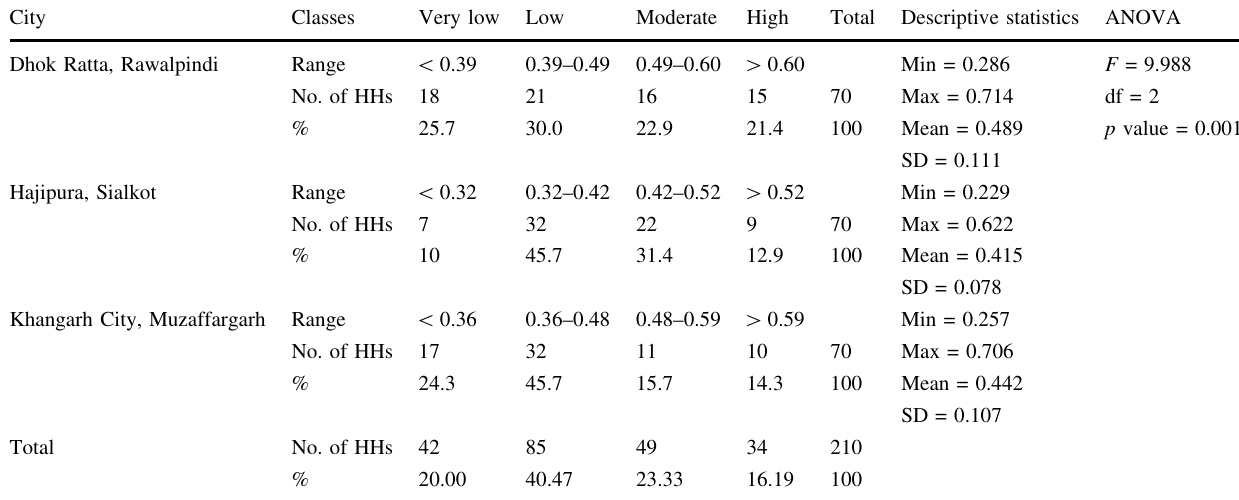
Table 2 Social vulnerability to urban flooding in Dhok Ratta, Hajipura, and Khangarh City, Punjab Province, Pakistan (HHs = Households; n = 210) City